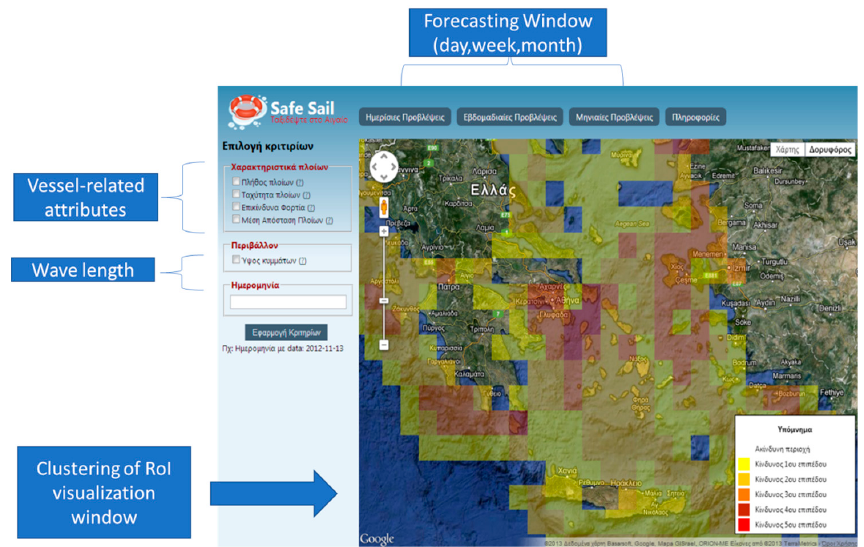
Figure 6. The outcome of the clustering approach.